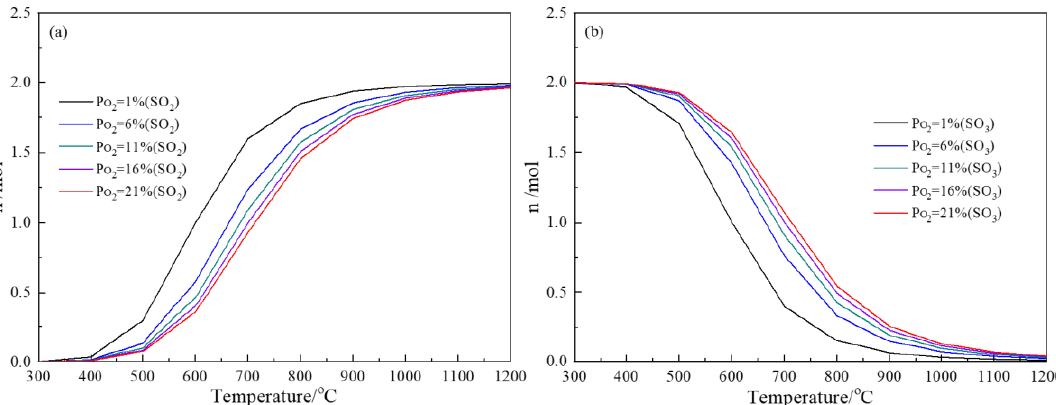
Figure 4. Formation of sulfur oxides in the oxidation of arsenic sulfide under different oxygen par- tial pressures and temperatures ( a ) SO 2 ; ( b ) SO 3 . pressures and temperatures ( a ) SO 2 ; ( b ) SO 3